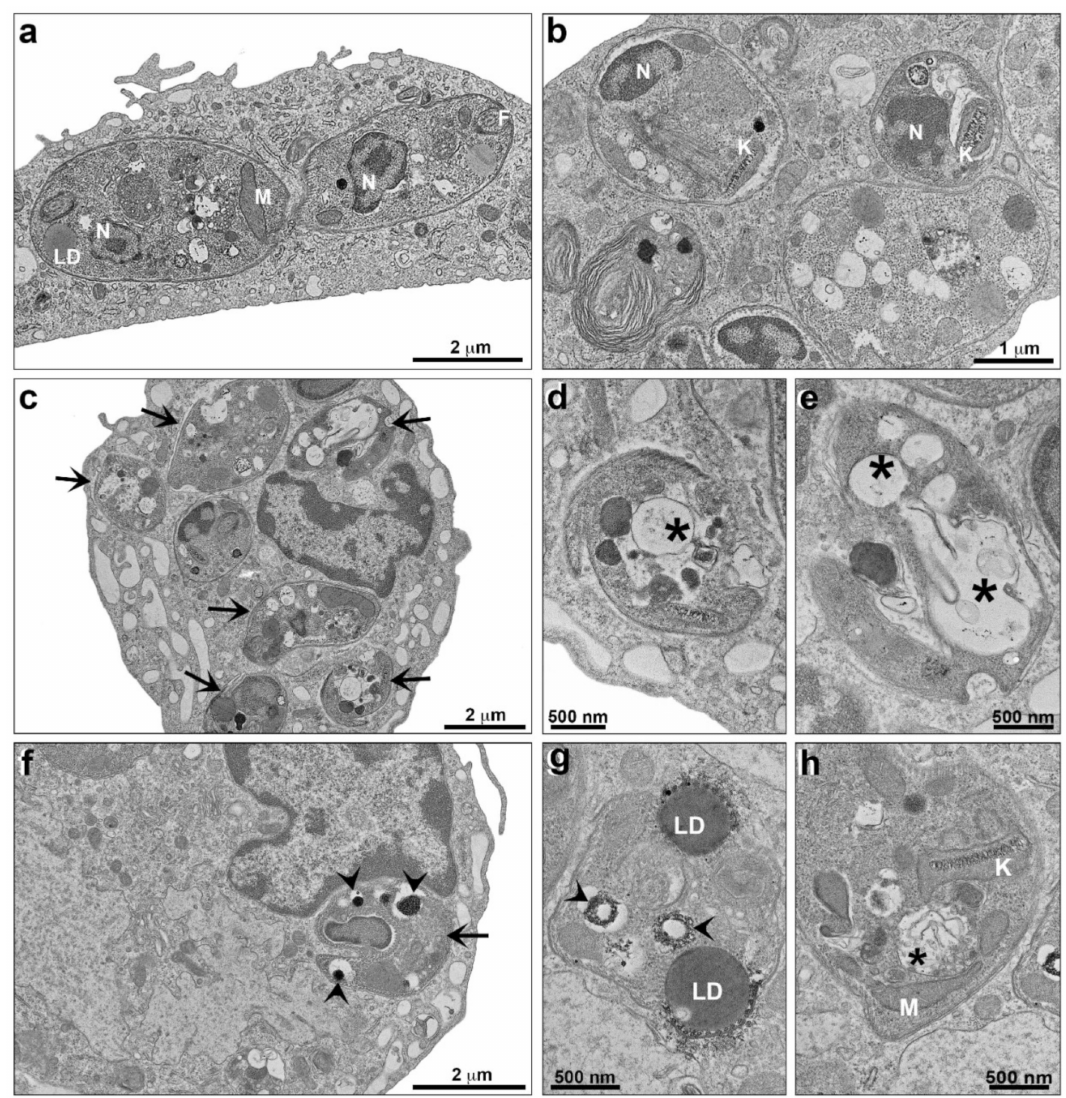
Figure 8. Ultrastructural analysis of L. infantum intracellular amastigotes treated with TPCK observed by TEM. ( a , b ) Control (untreated cells), amastigotes are seen inside parasitophorous vacuoles with a homogeneous cytoplasm and regular organelle aspects; ( c – e ) treatment with TPCK at 22 µ M, amastigotes are indicated with arrows ( c ). Large cytoplasmatic vacuoles with membranous profiles can be visualized ( d , e —asterisks); ( f – h ) treatment with TPCK at 44 µ M, an amastigote is indicated with an arrow ( f ). Electron dense material ( g —arrowhead) and a membranous profile ( h —asterisks) can be observed inside vacuoles. N, nucleus; LD, lipid droplets; M, mitochondria; K, kinetoplast; F,